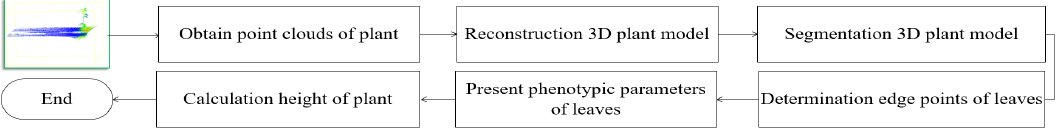
Figure 1. Flowchart of this paper for obtaining a plant’s morphological